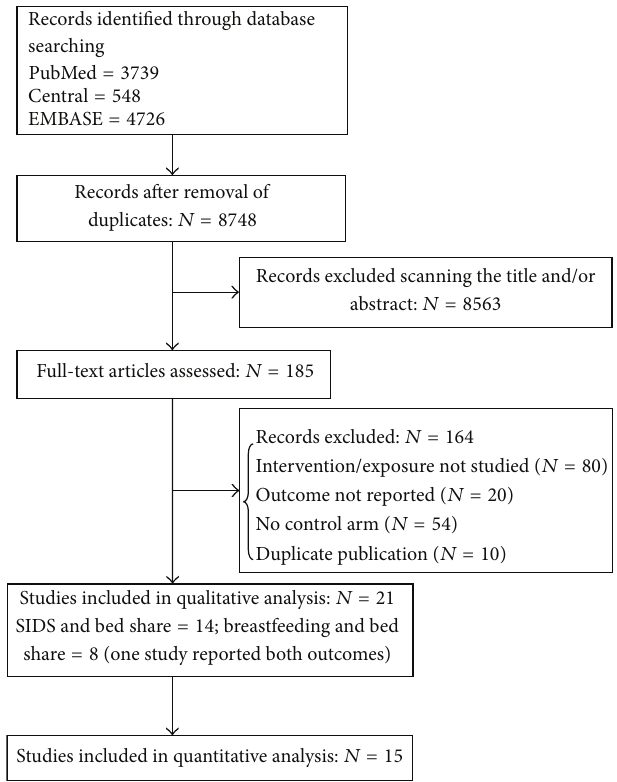
Figure 1: Flow of